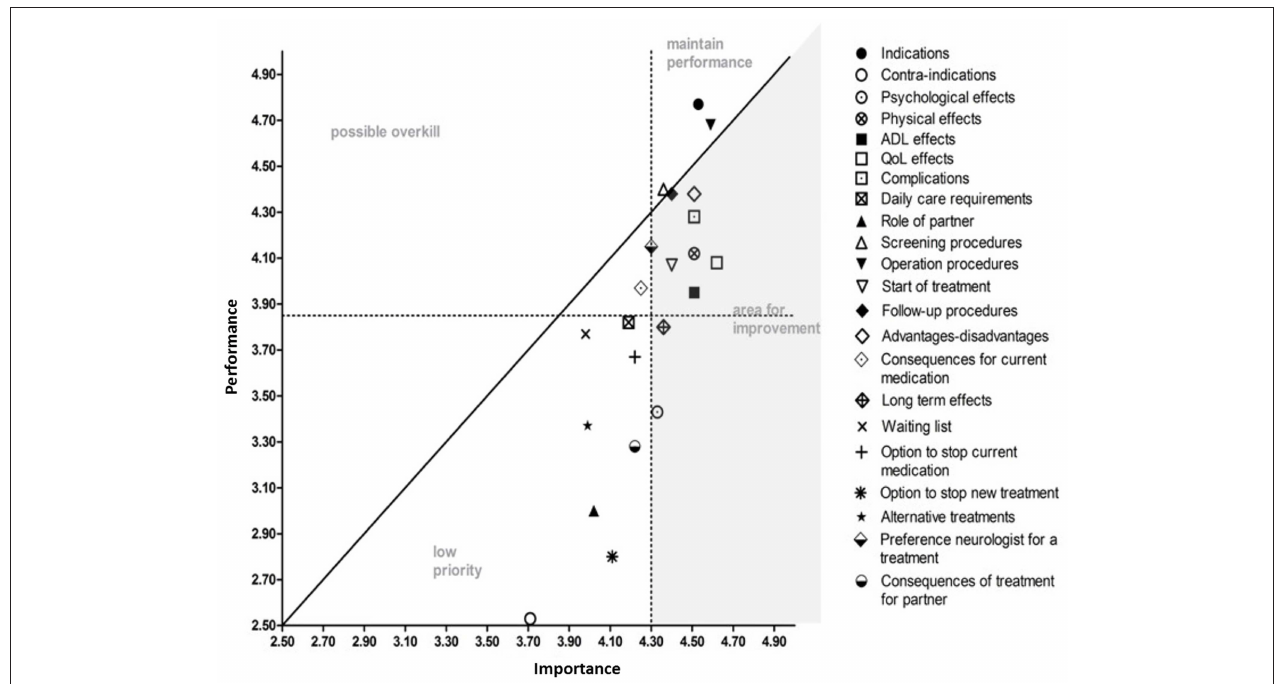
FIGURE 1 | Importance and Performance (IPA) analysis. All information attributes are displayed in random order. The attributes in the gray area represent the information attributes that need improvement. The attributes in the area of “maintain performance” scored high in importance and information provision; those attributes are sufficiently covered. The attributes in the area of possible overkill’ are attributes that were considered less important but were covered adequately in information provision. The area of “low priority” represents the attributes that were not sufficiently covered in information provision but were also considered less important. The information attributes are described in more detail in the questionnaire ( Supplement 1